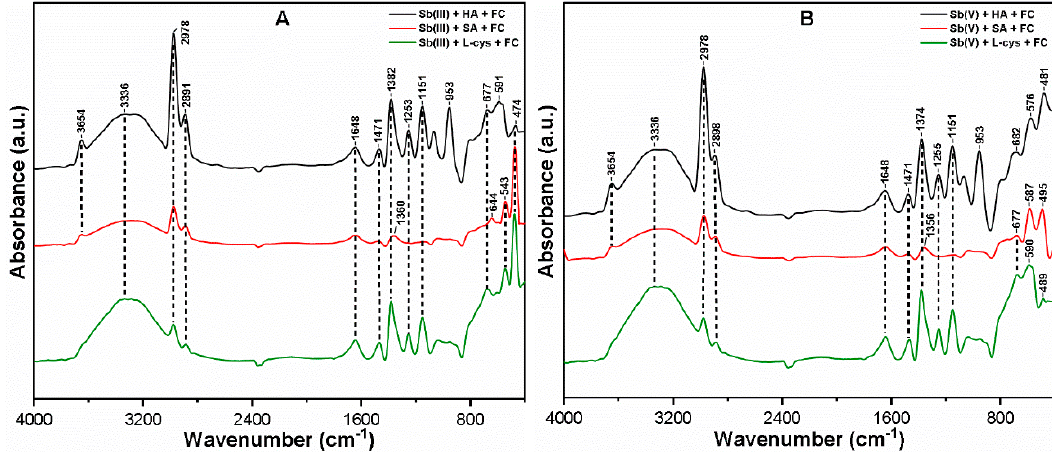
Figure 7. FT-IR spectra of FC composite flocs in the ternary system containing ( A ) Sb(III); ( B ) Sb(V) species at OD after the C–F process.